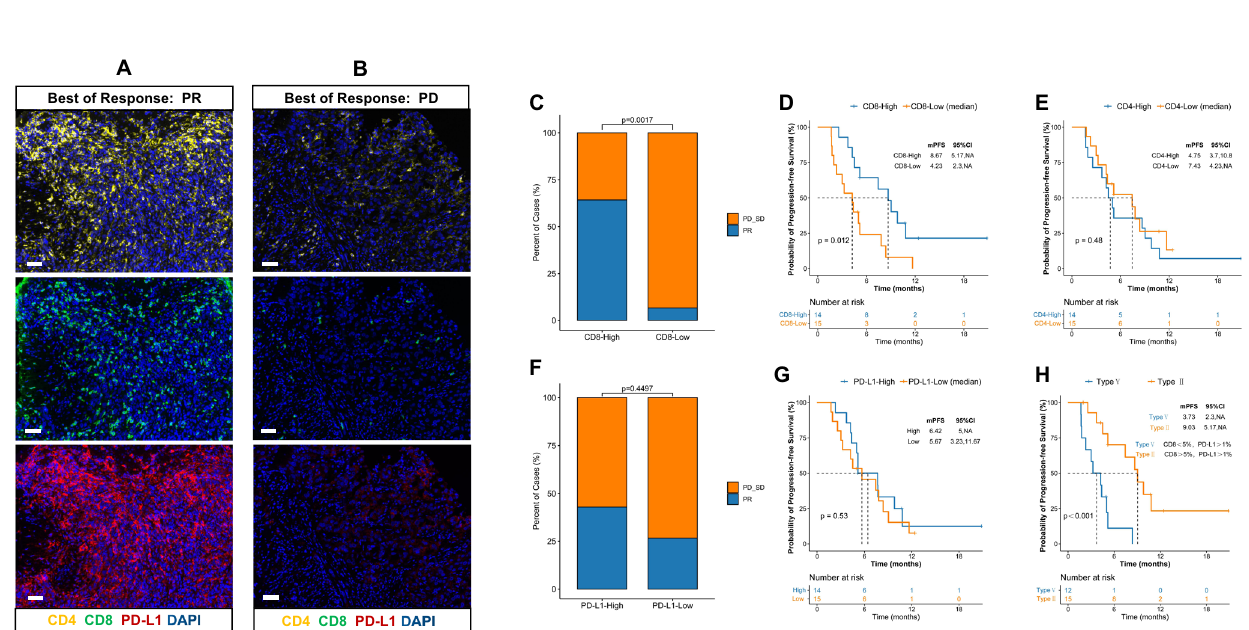
Fig. 5 | Additional immune signatures analysis in predicting tumor response. A Theexpressionof7genesetspreviouslyreportedtobeassociatedwithresponse toimmunotherapybetweenresponders( n =10)andnon-responders( n =18). B Five gene sets of prognostic value were differentially expressed between responders ( n =10) and non-responders ( n =18), box plots are indicated in terms of minima, maxima, centre, bounds of box and whiskers (interquartile range value), and per- centile in the style of Tukey, Wilcoxon test was used to determine the statistical signi fi cance between subgroups. C – E Higher ORR and longer PFS were associated withhigherexpressionof3-geneeffectorTcellsignature,9patientsachievedPRin the higher expression of 3-gene effector T cell signature group ( n =14), and